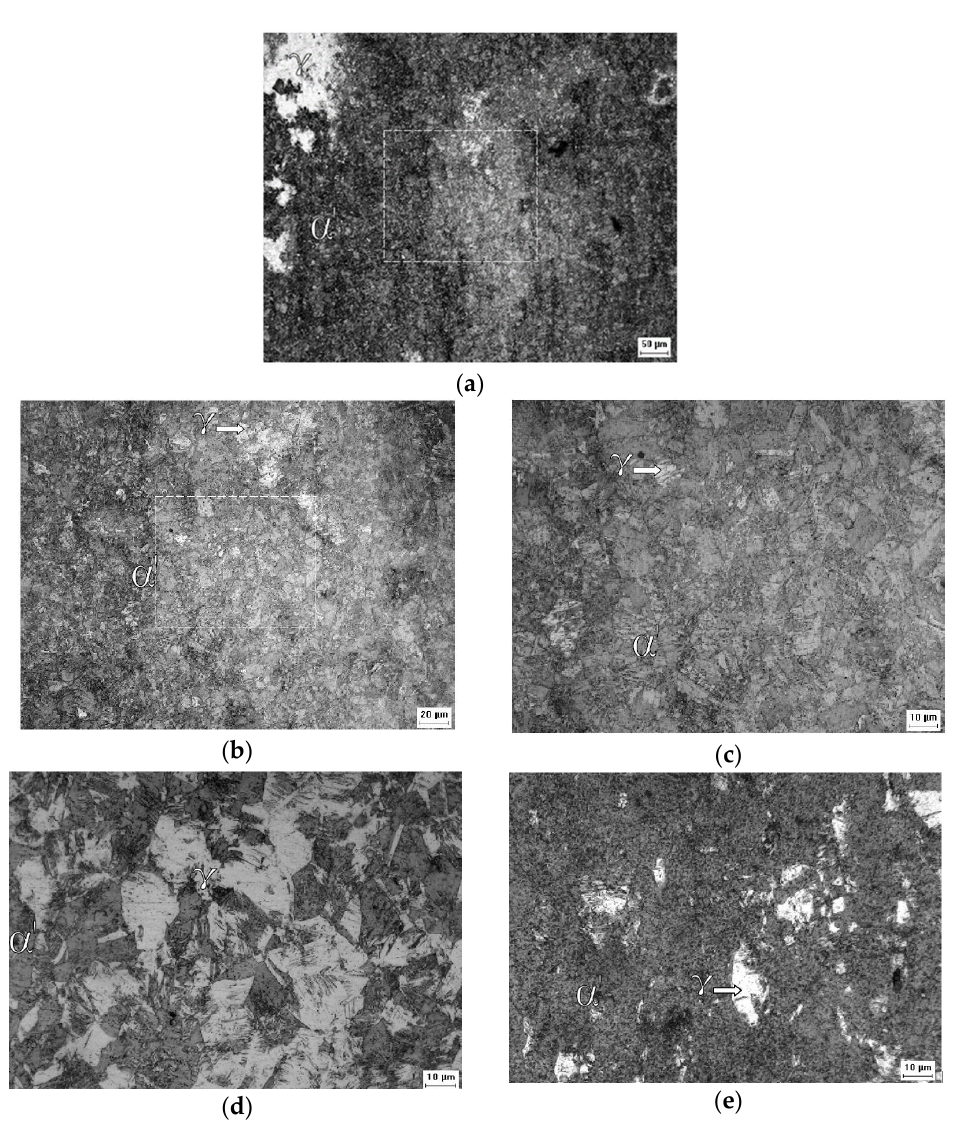
Figure 3. Micrographs of the A0 sample at ×200 ( a ), ×500 ( b ), and ×1000 ( c ), and of the A1 sample at ×1000 ( d ) and of the A2 sample at ×1000 ( e ) magnification after the Behara ’ s reagent attack. Table 6. Thickness, volumetric fraction, standard deviation, and crystalline domain for the studied AISI 301LN and 316L steels.